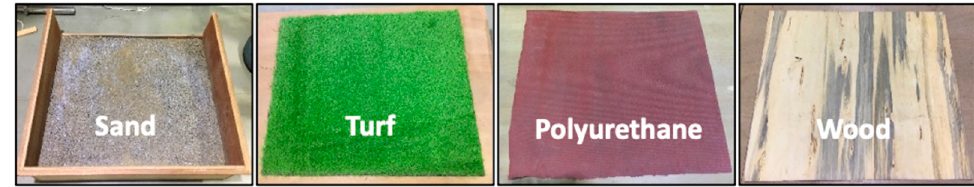
Figure 2. Four common material surfaces on sports fi elds.